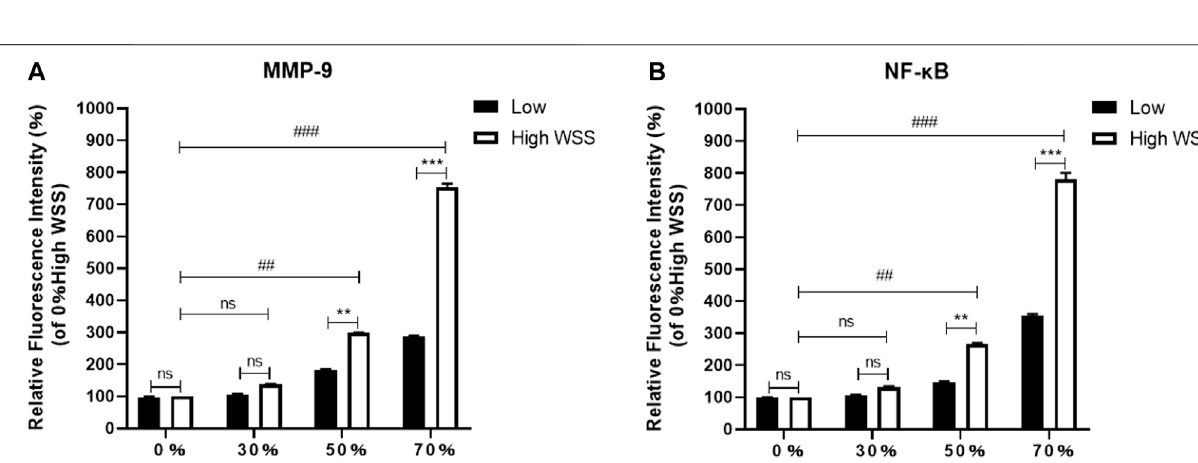
Frontiers in Bioengineering and Biotechnology |